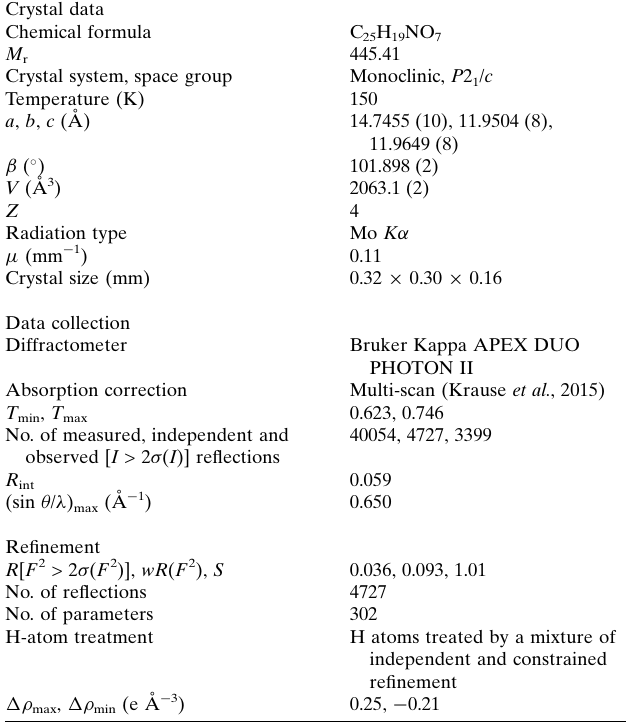
Table 2 Experimental details. Crystal data Chemical